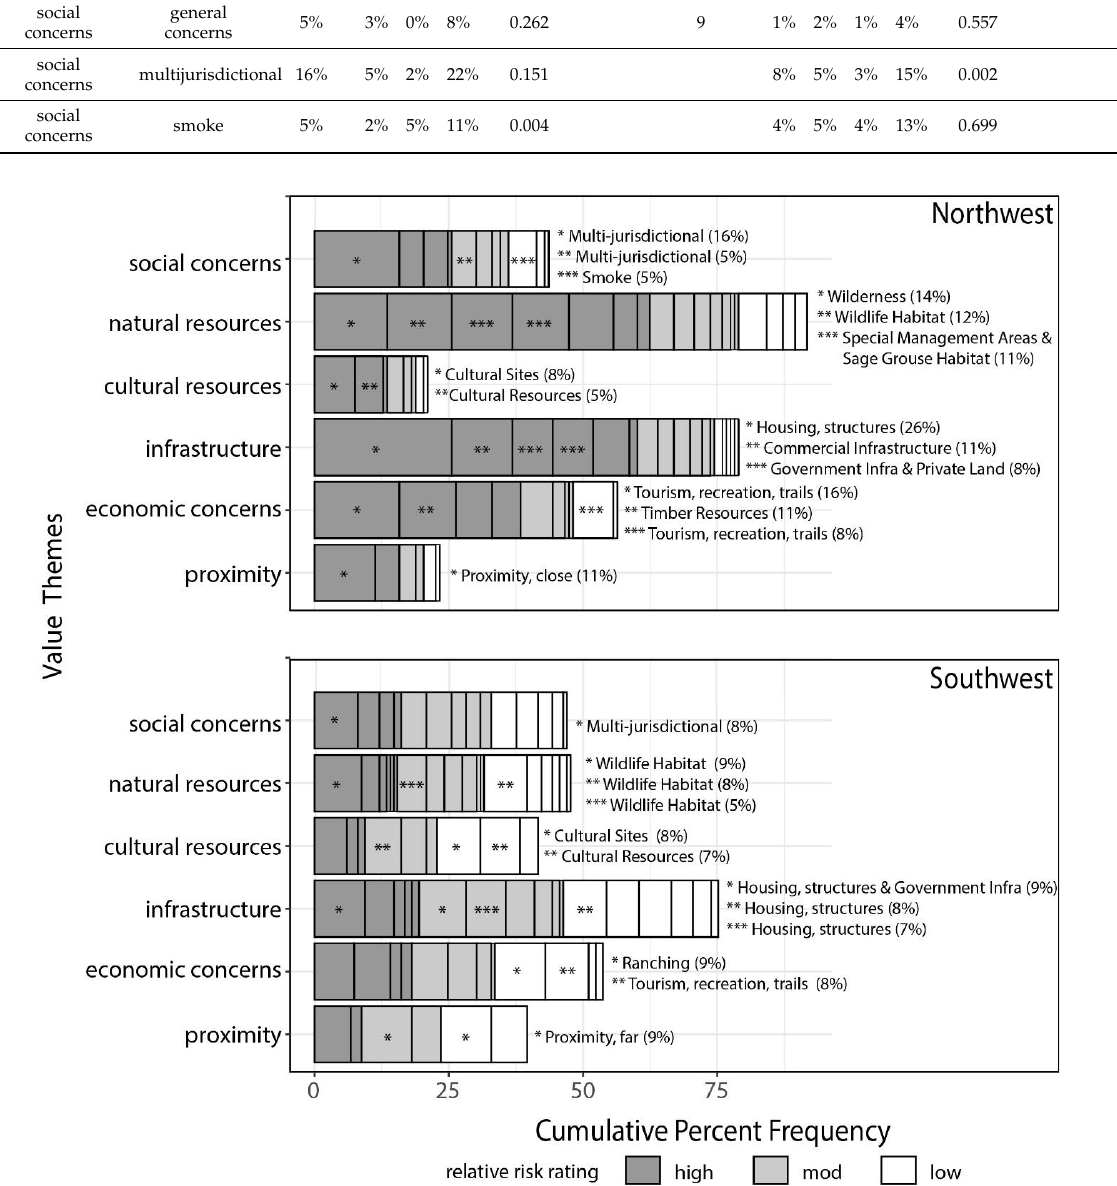
Figure 4. Cumulative percent frequency of codes summarized with ‘Value’ themes by high, moderate and low relative risk ratings for the Northwest and Southwest Geographic Areas (GAs). The most common codes and their percent frequency are listed in the figure and available in Table 2 and Appendix B.